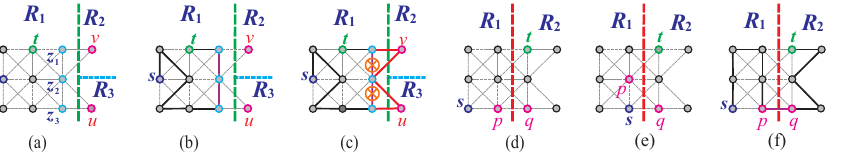
Figure 14. ( a ) A vertical and a horizontal separation on C ( m , n ; k , l ; c , d ) under that s x , t x < m −